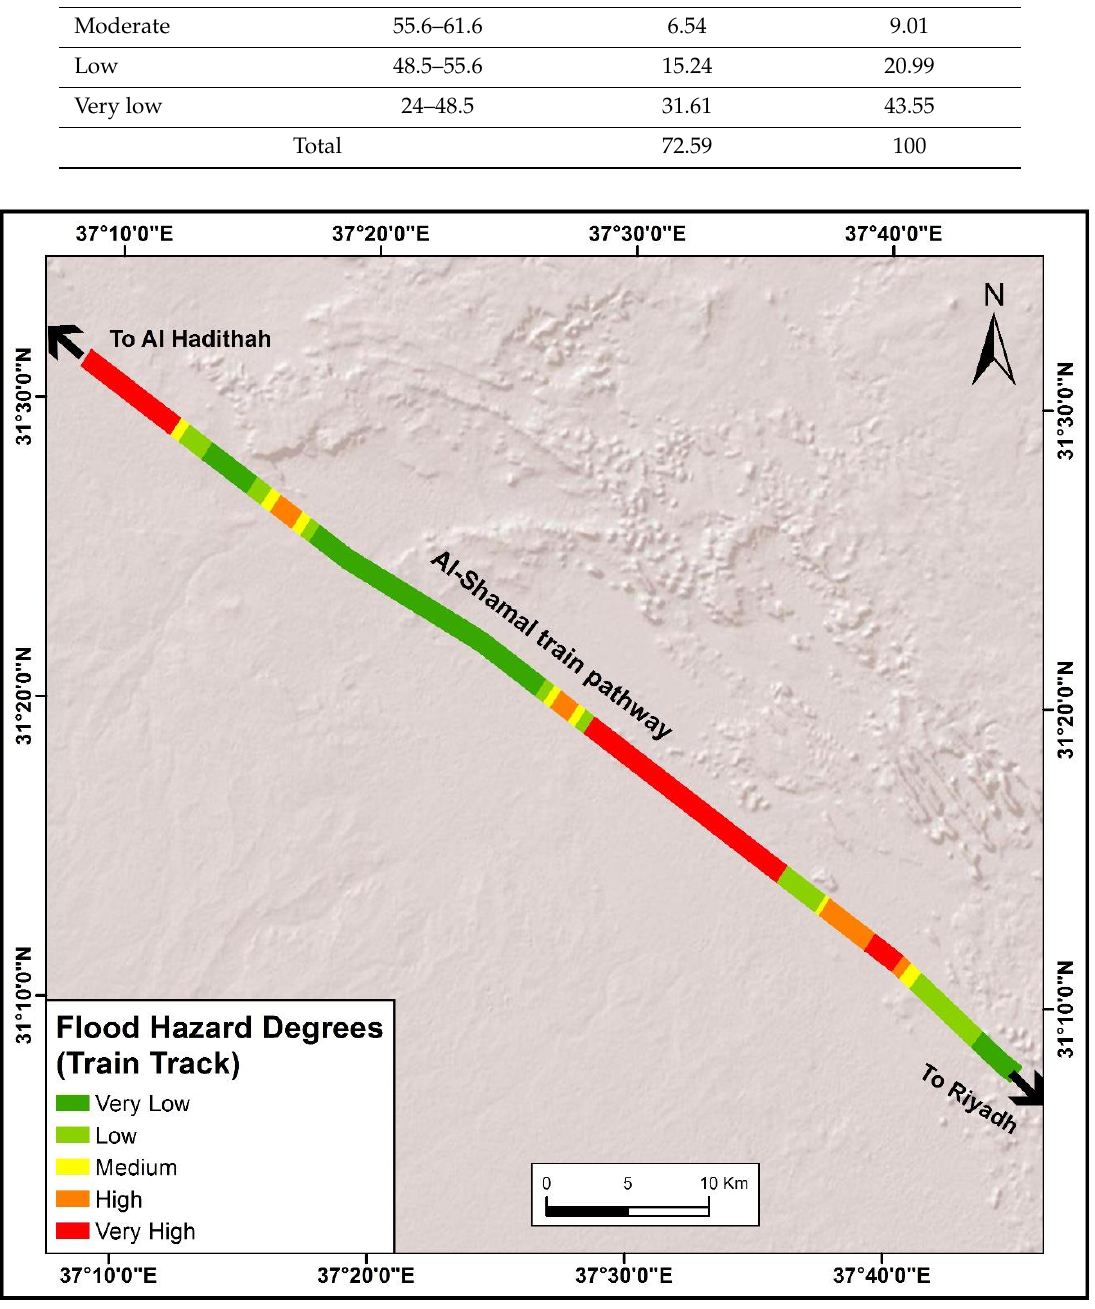
Table 21. Flood hazard degrees on the Al-Shamal train pathway in the study area in 2020.